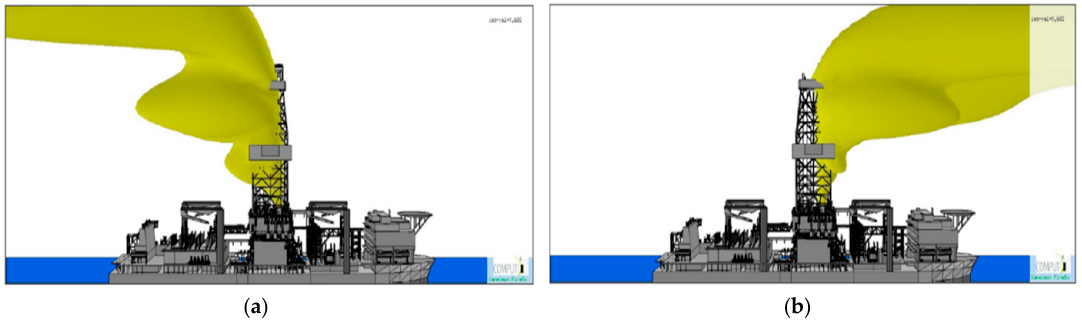
Figure 5. Iso-surface with 20% LFLlower flammable limit ( = 0.682%) when gas is released on the drill floor with full flowrate and 5.4 m/s wind blows from ( a ) the forward ( b ) and aft directions.